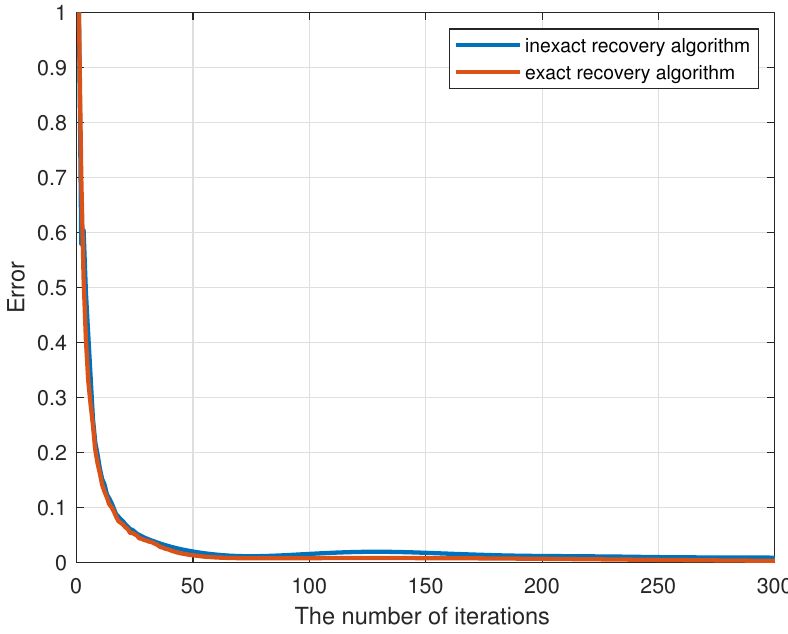
Figure 10. Convergence error curve of both